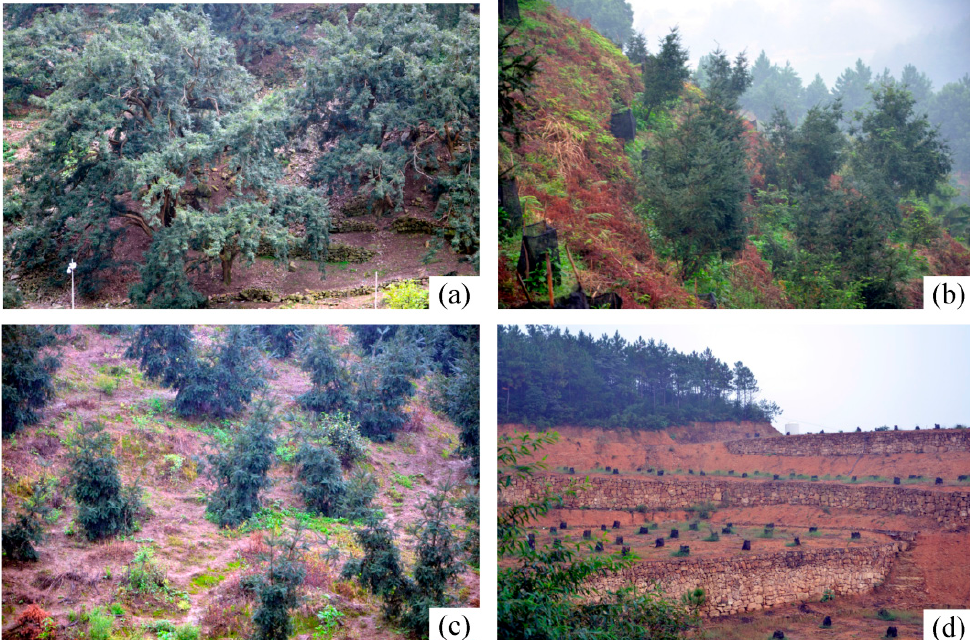
Figure 2. Photos (taken in September 2015) of Torreya forests with various ages: ( a ) old Torreya forest, aged hundreds of years; ( b , c ) young plantations between 8 and 16 years old; and ( d ) new Torreya plantation without grass and shrub covers.